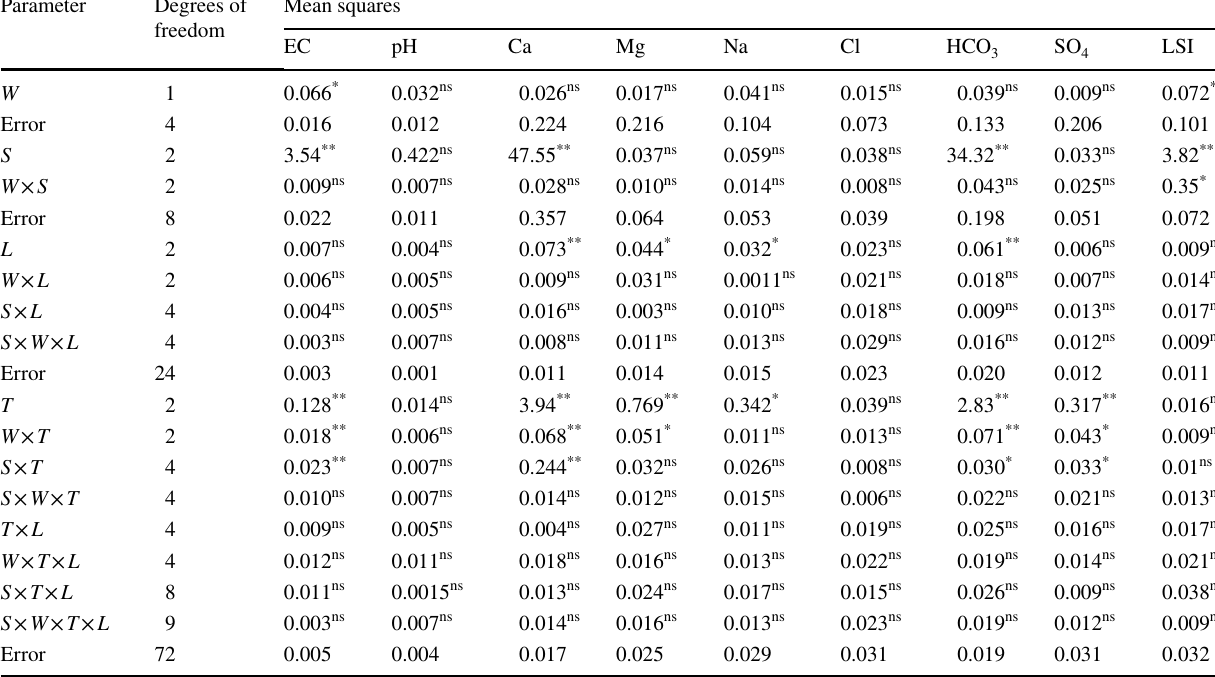
Table 2 Analysis of variance for the measured parameters of irrigation treatments